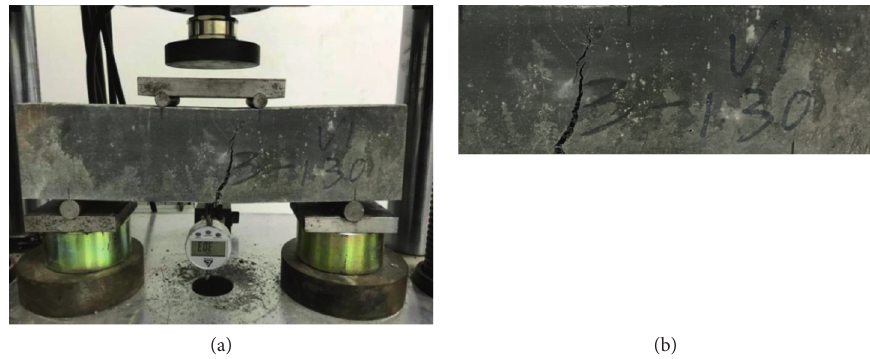
Figure 2: Before and after cropping. (a) Before cropping. (b) After cropping.